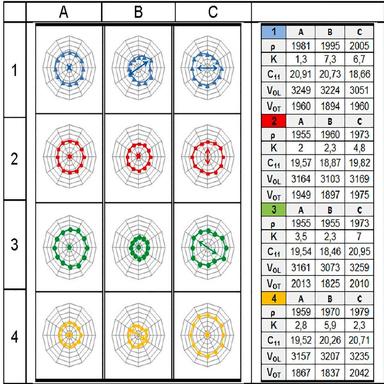
Polar diagrams, main directions of fiber and the table of the characteristics in RO-A-SMC (A–C: vertical sample location and 1–4: horizontal sample location).